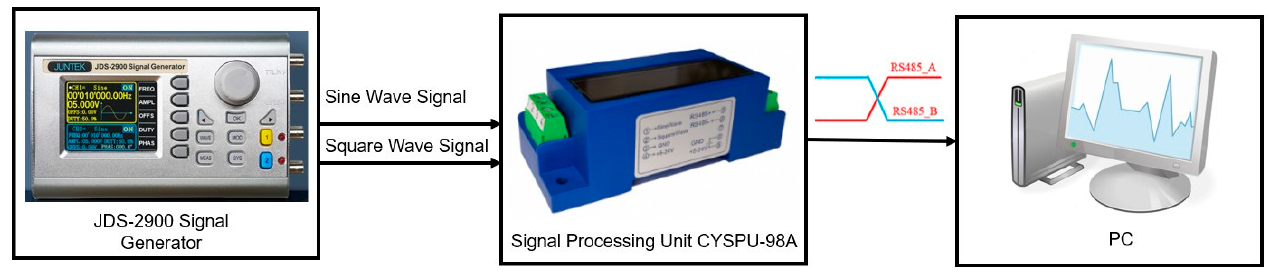
Figure 8. Block diagram of the signal generator-based frequency test system.